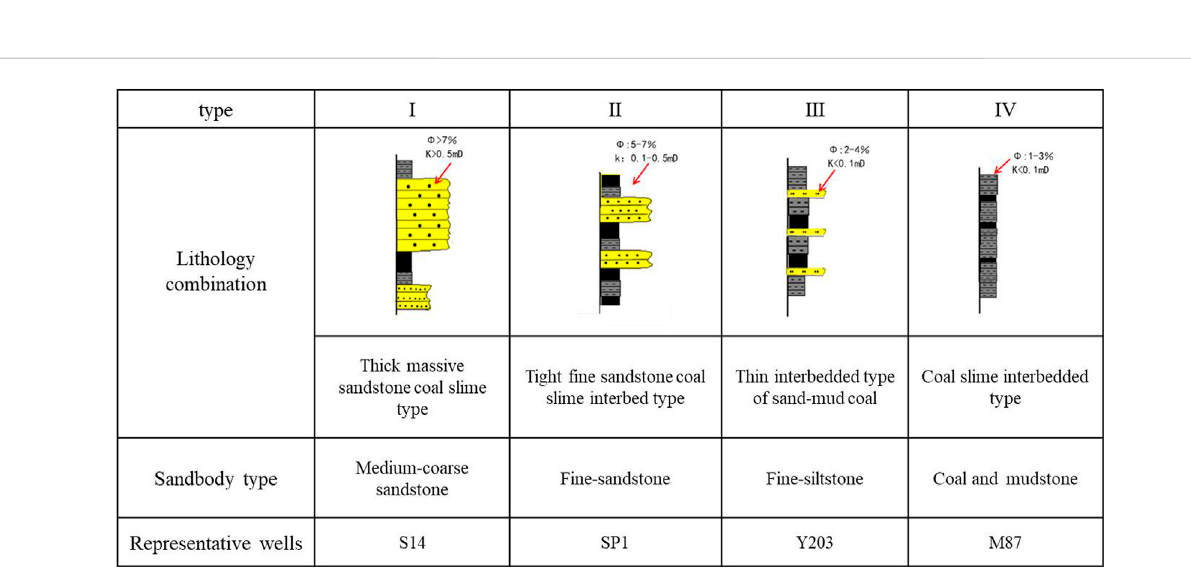
FIGURE 2 Classi fi cation of Shan 2 coal measure gas in the Ordos